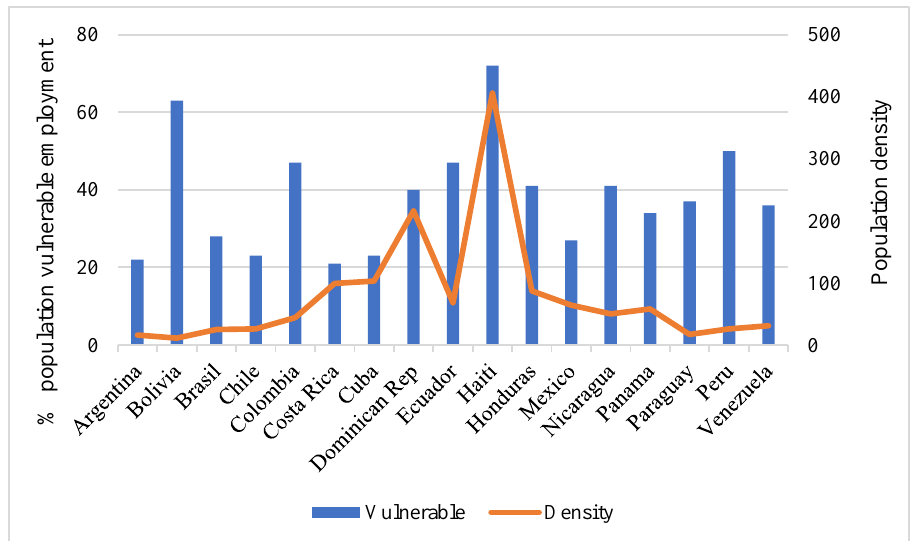
Figure 2. Percentage of population in vulnerable employment and population density. Source: own elaboration based on data provided by the World Bank.